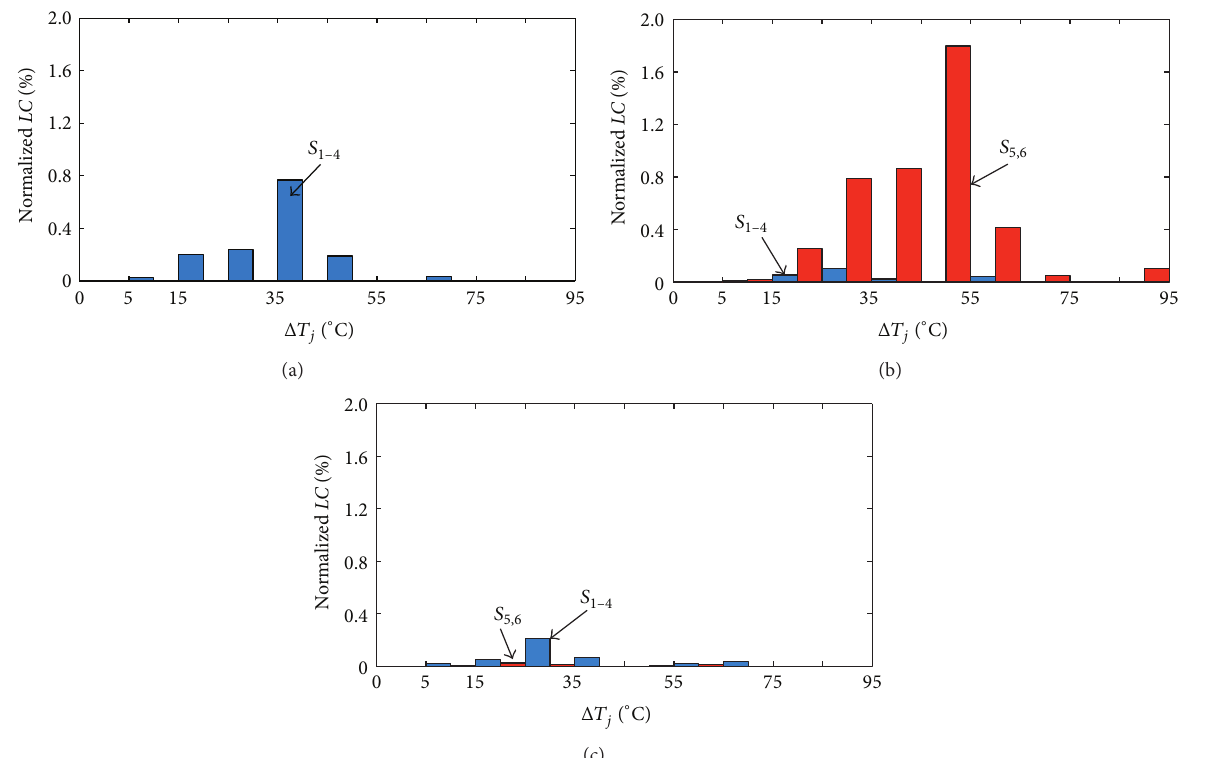
Figure 11: Normalized life consumption (lifetime comparison) of the three transformerless PV inverters under the same mission profile: (a) FB-Bipolar inverter, (b) H6 inverter, and (c) HERIC inverter.